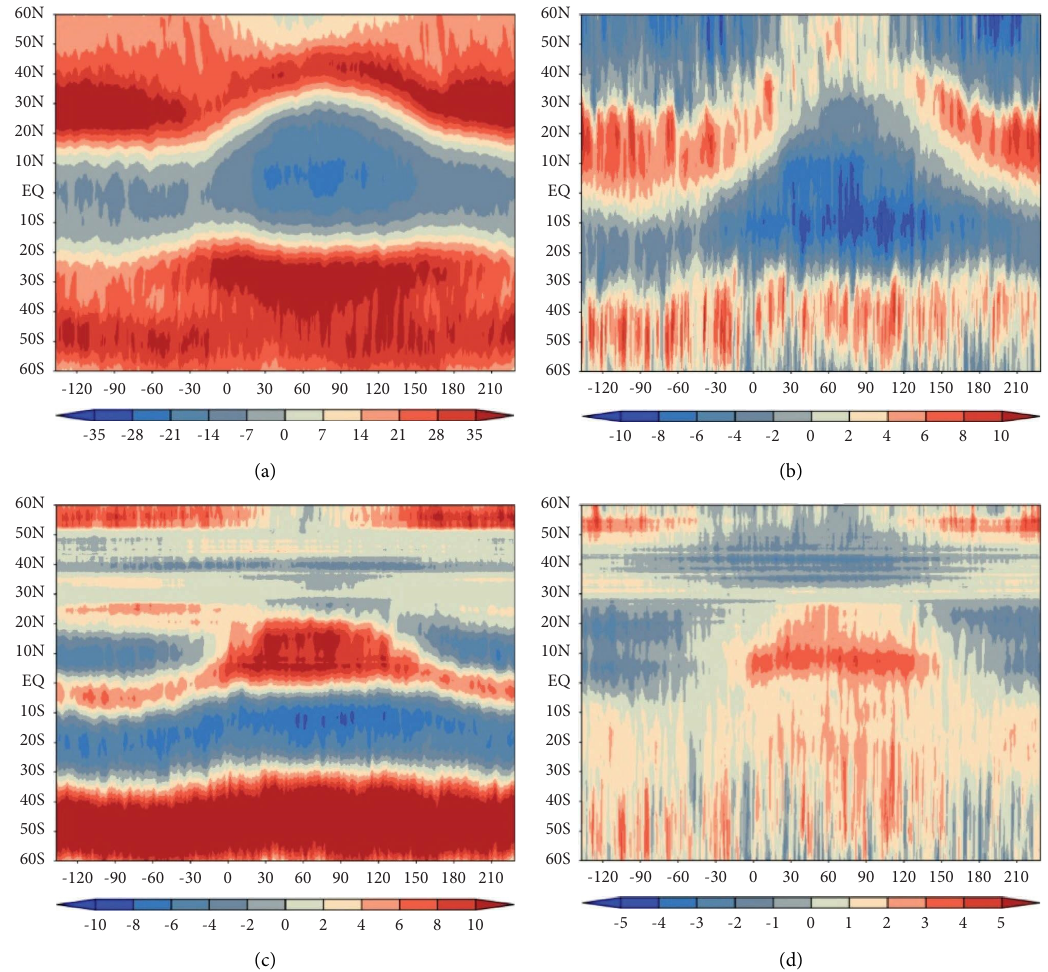
Figure 9: Climatological (1991–2020) composites centered on onset date, averaged over 90–105 ° E: (a) 200hPa zonal ( U 200hPa meridional ( V 200 ) wind (m · s − 1 ), (c) 850hPa zonal ( U 850 ) wind (m · s − 1 ), and (d) 850hPa meridional ( V 850 ) wind (m · s − 1